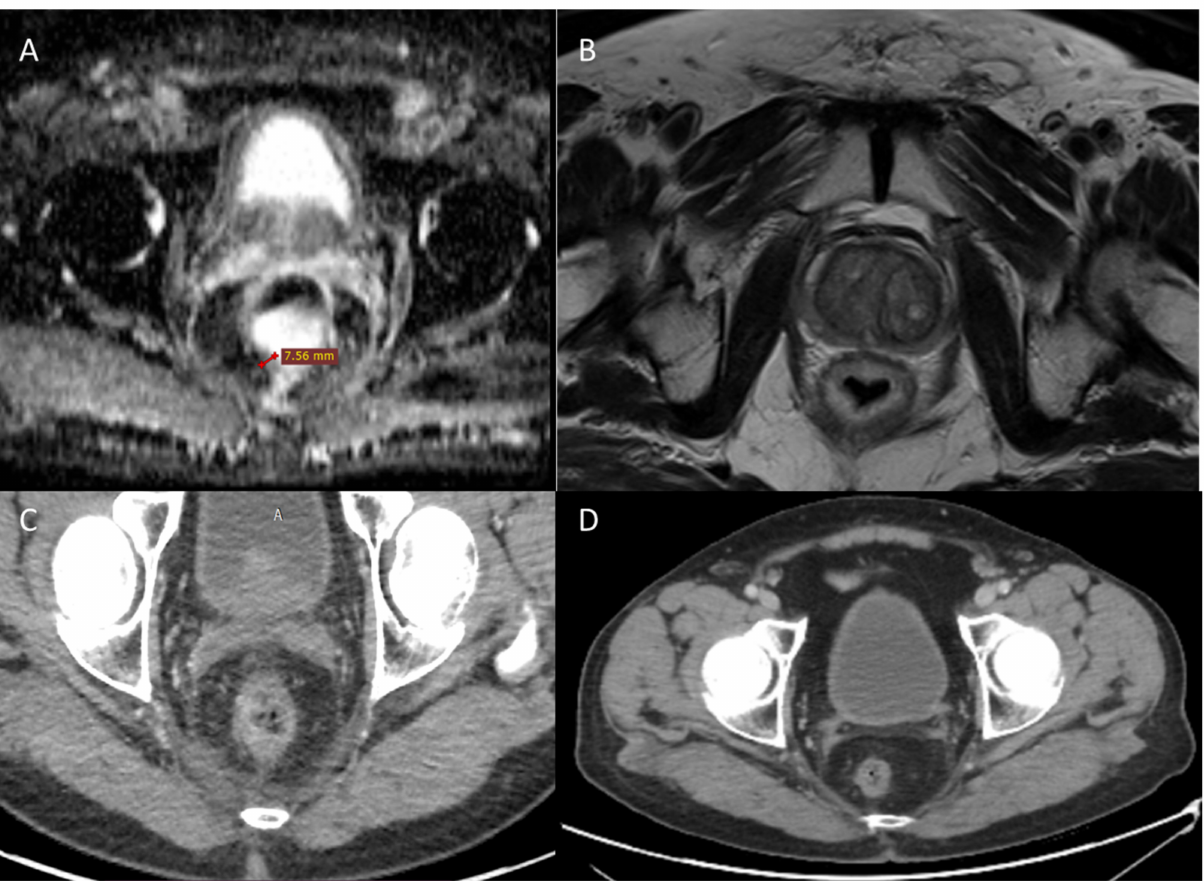
Figure 4. MR and CT images ( A , B ) before treatment of first case and CT images at 6 and 9 months after ECT treatment in ( C , D ),